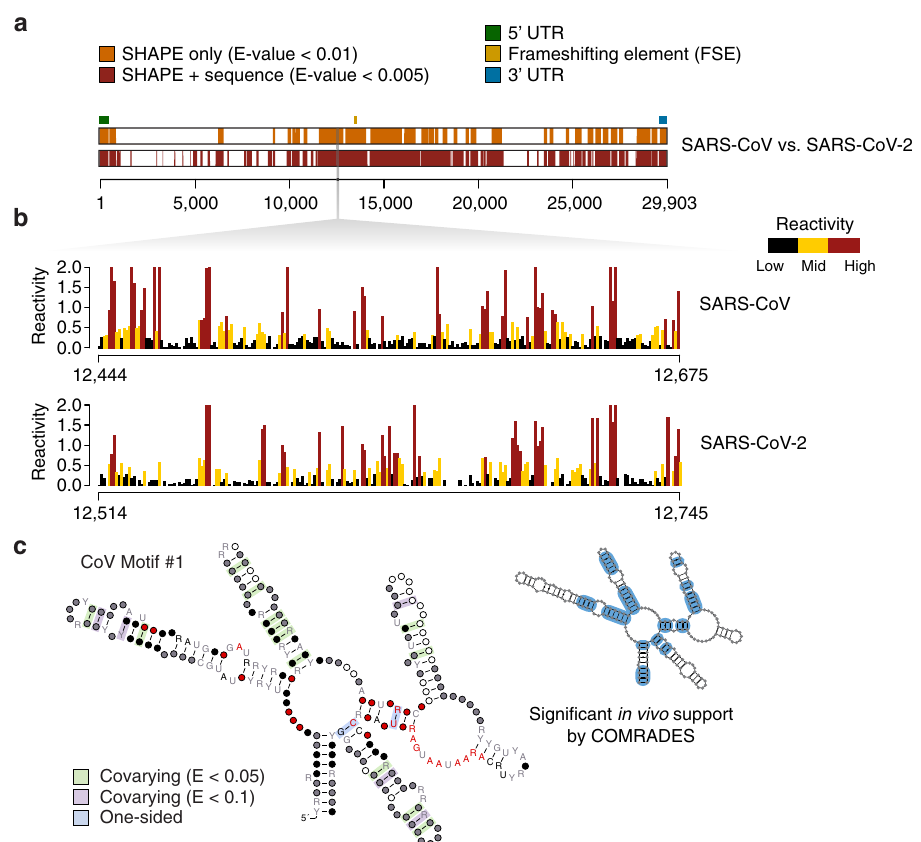
Fig. 3 SHAPEwarp identi fi es novel highly-conserved viral RNA structures. a Signi fi cant matches between SARS-CoV (query) and SARS-CoV-2 (database), identi fi ed by SHAPEwarp, either in SHAPE only (orange) or SHAPE + sequence (red) mode. The relative position of known RNA structure elements (5 ′ UTR, FSE and 3 ′ UTR) is indicated. b Aligned SHAPE reactivity pro fi les for one of the identi fi ed structurally-conserved regions (CoV Motif #1). SHAPE reactivities have been capped to 2. c Structure model for CoV Motif #1. Structure was generated using R2R 43 . One-sided covariations were inferred from R2R output. Base pairs showing signi fi cant covariation (as determined by R-scape) are boxed in green ( E value < 0.05) and violet ( E value < 0.1) respectively. The inset illustrates base pairs having signi fi cant RNA – RNA chimera support from in vivo COMRADES, boxed in